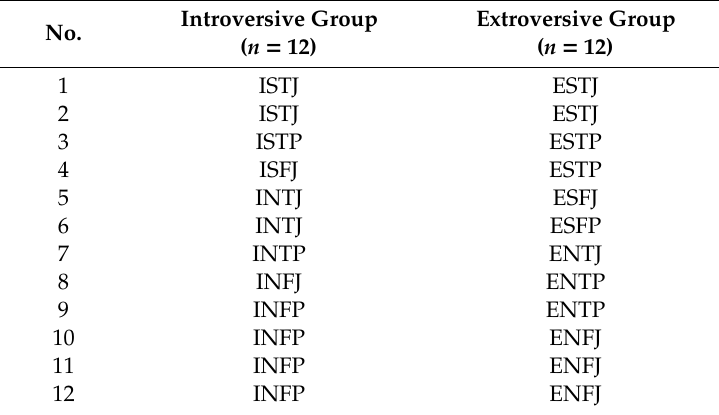
Table 1. The MBTI personality classes of the participants in this study. Introversive Group No. ( n = 12)